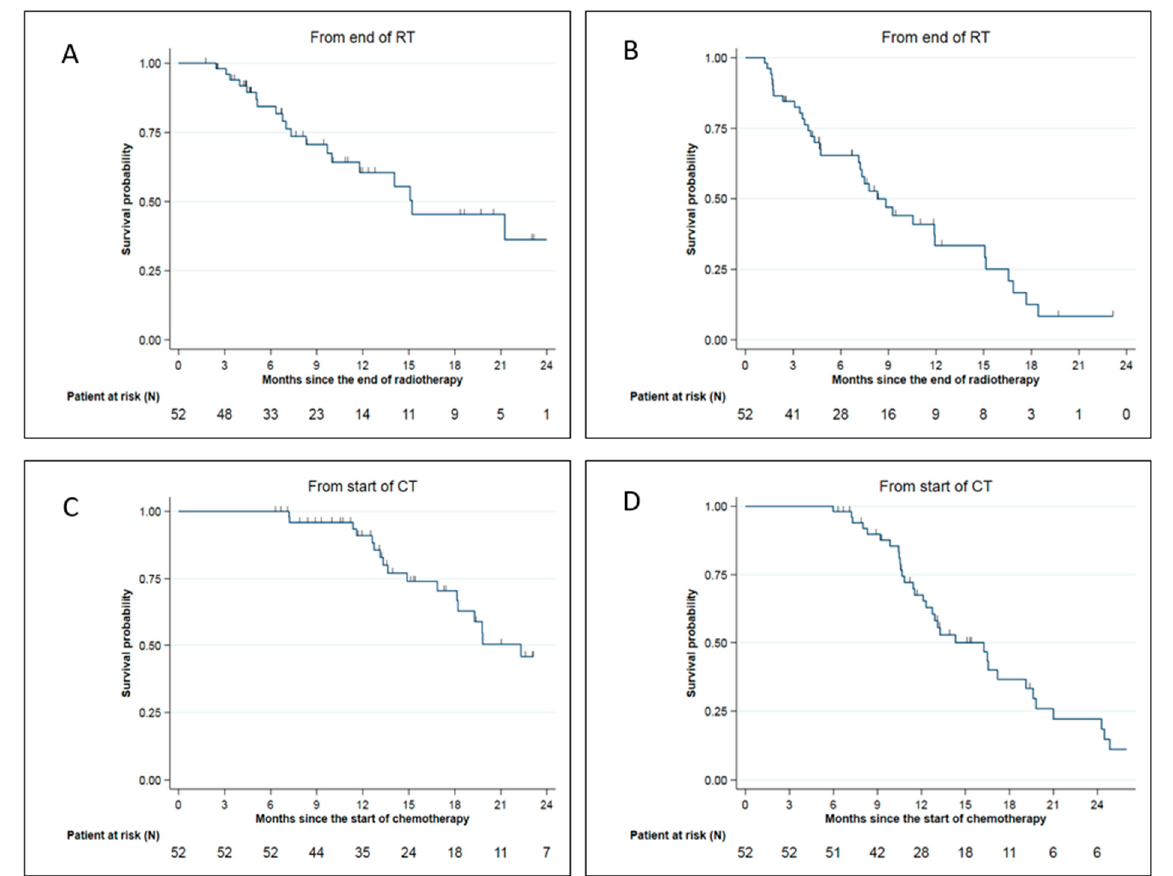
Figure 3. Survival data for LAPC and BRPC patients: ( A ) Overall survival from SMART completion; ( B ) Distant metastasis-free survival from SMART completion; ( C ) Overall survival from chemotherapy start; ( D ) Distant metastasis-free survival from chemotherapy start.